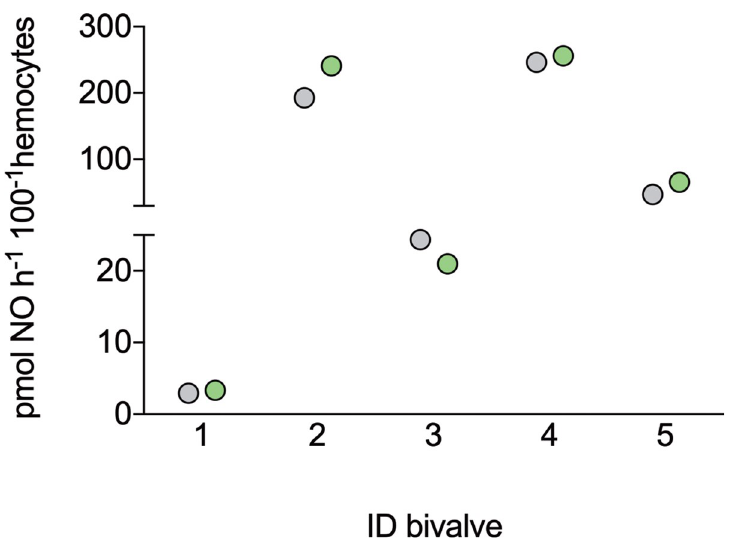
Fig 3. Nitric-oxide formation rates of live hemocyte cells of five individual Arctica islandica (ID 1–5) at 6 kPa p O 2 with (green circles) and without the nitric oxide synthase inhibitor L-NAME (grey circles). Measurements conducted with an ISO-NOP